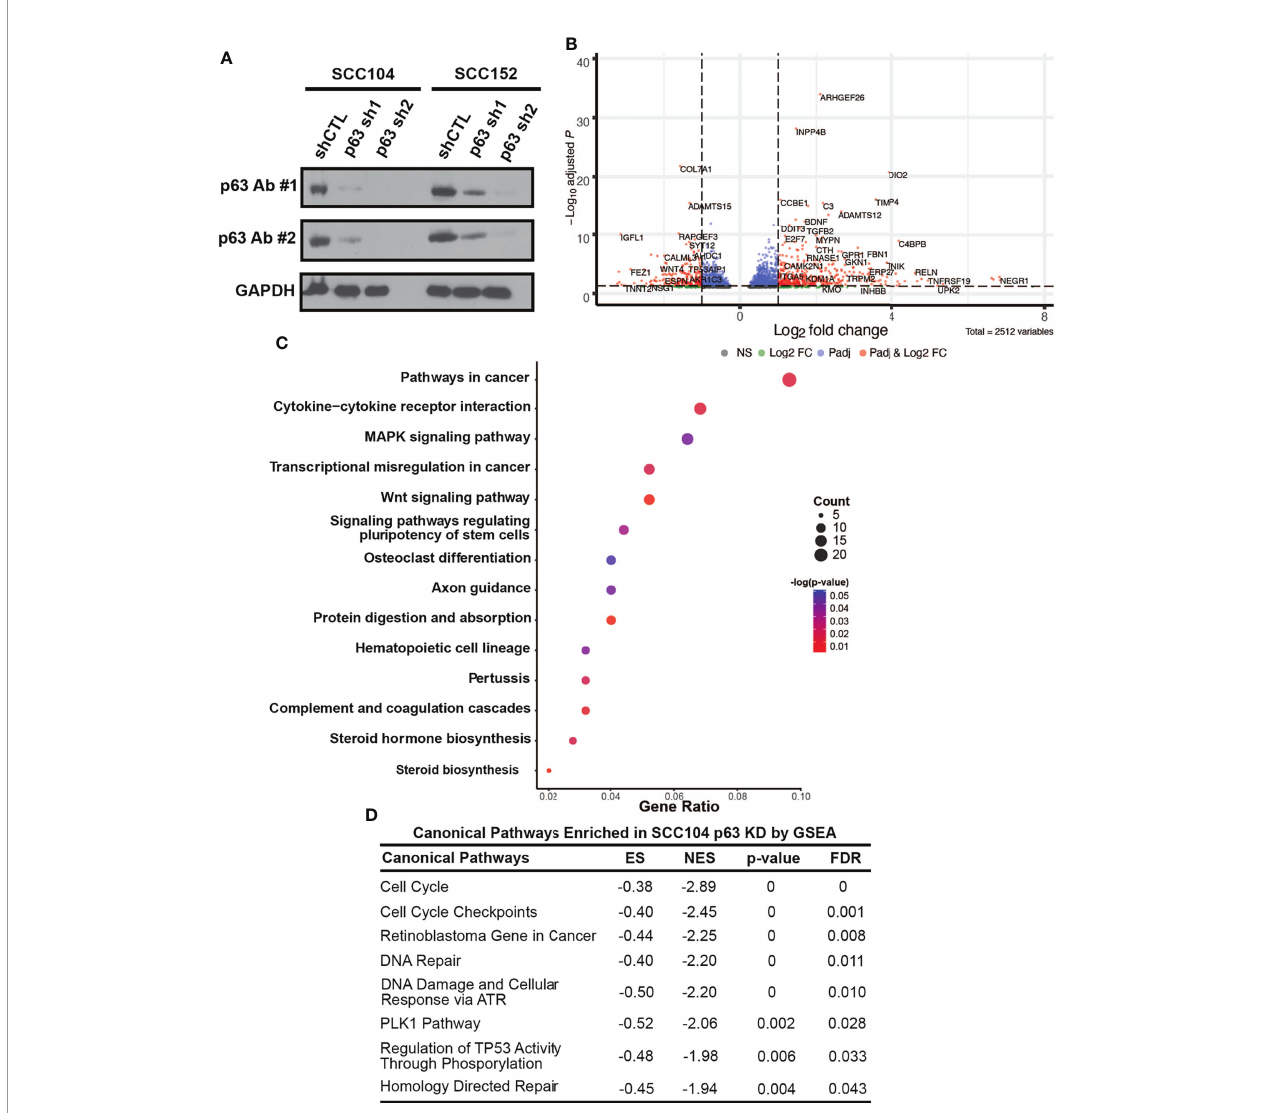
FIGURE 4 | p63 knockdown in SCC104 shows enrichment of HPV-associated signaling pathways. (A) Western blot analysis of p63 expression in SCC104 and SCC152 cells expressing either p63-targeting shRNAs or a nontargeting shRNA (shCTL). GAPDH: loading control. (B) Volcano plot of DEGs resulting from p63 knockdown in SCC104 cells. (C) KEGG pathway analysis of SCC104 DEGs whose expression showed ≥ log2 fold change of 1. (D) Gene set enrichment analysis (GSEA) of DEGs from p63 knockdown in SCC104